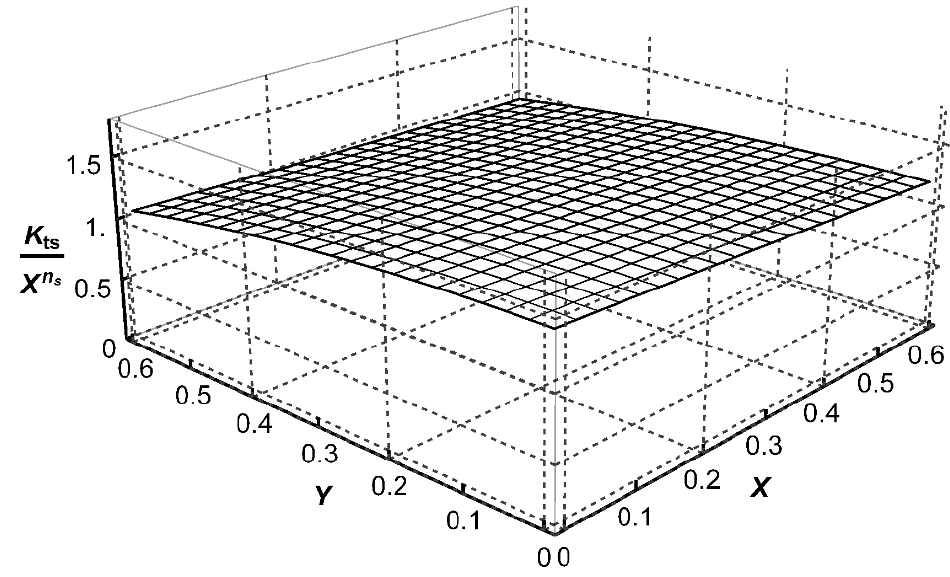
Figure 9. Graphical representation of the function P s = K ts / X n s for θ = 45 ◦ , n s = − 0.2 and Z 0 = 1.